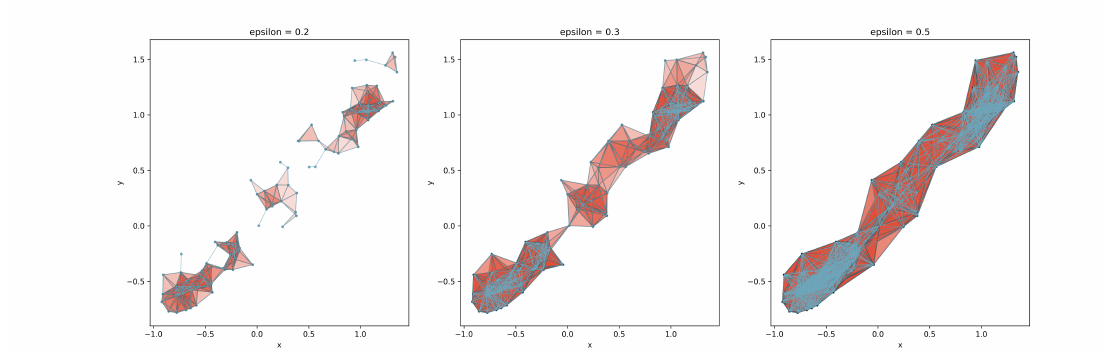
Figure 2. Examples of simplicial complexes. The color of triangles indicate solid surface; epsilon indicates the maximum edge length between any two points.